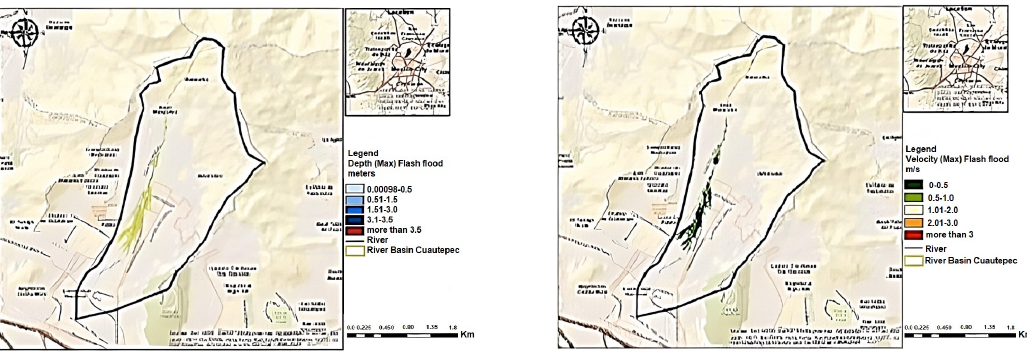
Figure 11. Depths and maximum velocity, maps for Historic flash flood using Hec ‐ Ras2d. The most extensive simulation (of 7.5 h) carried out by Hec ‐ Ras 2d reported maxi ‐ mum depths of the order of 3.1 m and a maximum velocity that reached 3 m/s; after 6 h, water drained into the basin outlet. The Manning N coefficient was set with different val ‐ ues, according to soil type. 3.5. Flash Flood for Tr = 50 Years The reported maps and velocities from simulation with Hec ‐ Ras 2d for flash flood for Tr = 50 and Tr=100 years are shown in Figures 12 and 13.